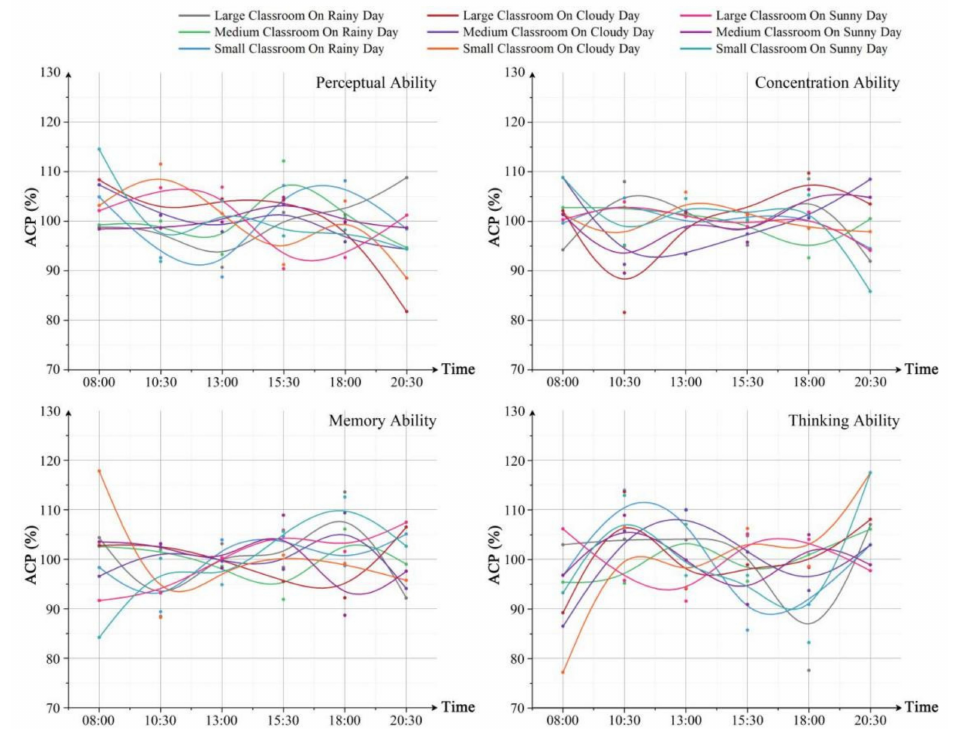
Figure 15. The ACP of the four dimensions in the three classroom-types under different weather conditions throughout the